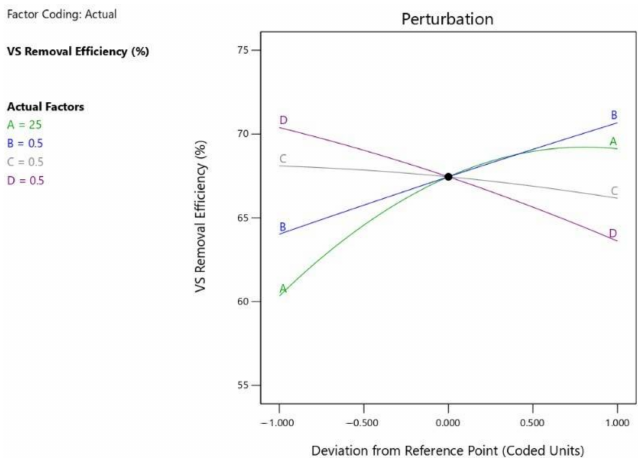
Figure 6. Perturbation plots for VS removal efficiency